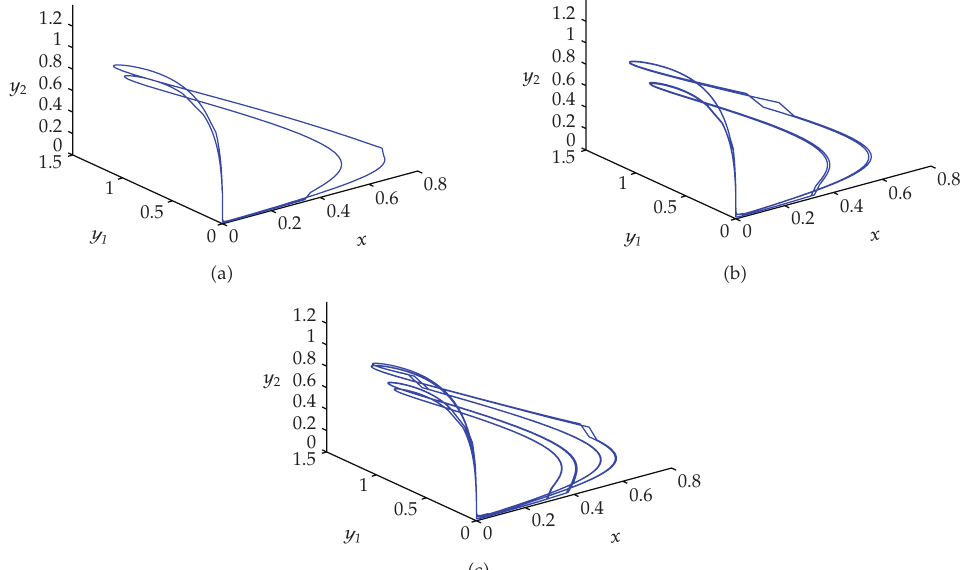
Figure 7: Period doubling cascade: (cid:2) a (cid:3) phase portrait of 2 T -periodic solution for q (cid:6) 0 . 05; (cid:2) b (cid:3) phase portrait of 4 T -periodic solution for q (cid:6) 0 . 08; (cid:2) c (cid:3) phase portrait of 4 T -periodic solution for q (cid:6) 0 .